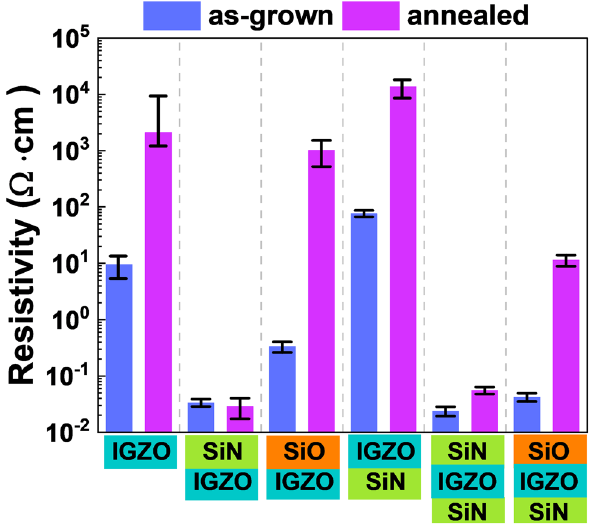
Figure 2. Electrical properties of as-grown and annealed a -IGZO films with different structures of passivation or gate insulator